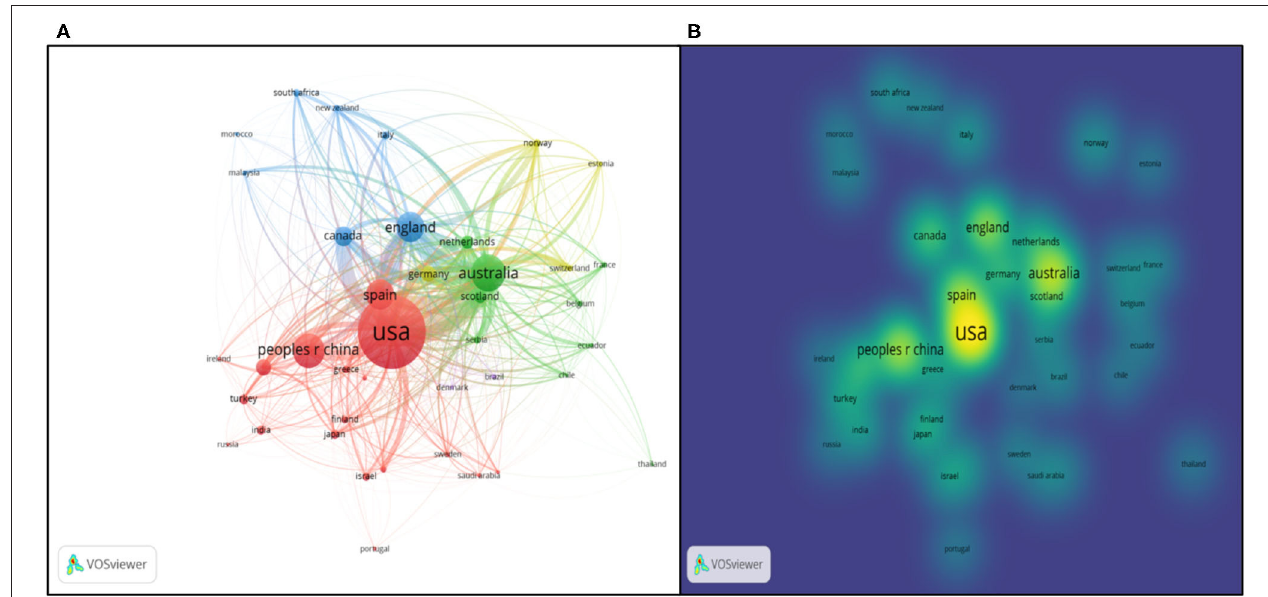
FIGURE 11 | Citation analysis of geography. (A) Network visualization map based on citation weights; (B) Density Visualization based on citation